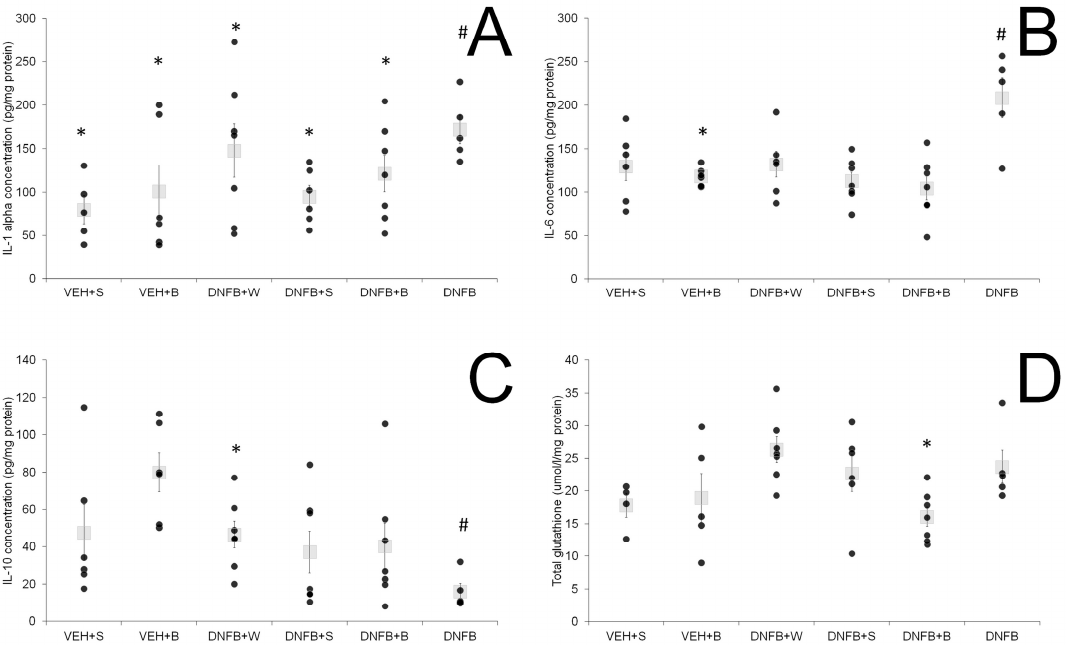
Figure 4. IL-1 α ( A ), IL-6 ( B ), IL-10 ( C ) and total glutathione ( D ) levels in lung tissue. # p < 0.05 vs. VEH + S (Mann–Whitney U test); * p < 0.05 vs. DNFB (Mann–Whitney U test); means ±